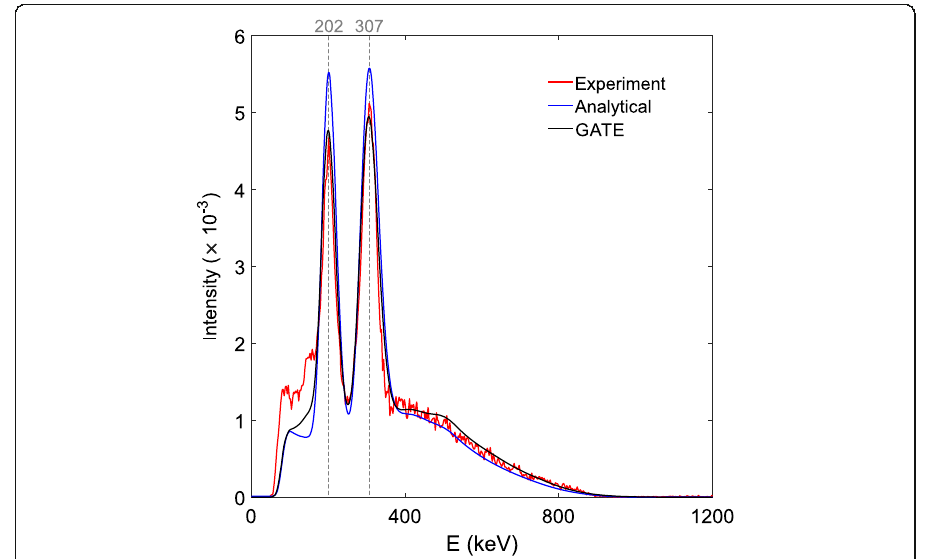
Fig. 7 Normalized coincidence energy spectra for two small LYSO cubes (10-mm side length) in contact ( d = 0 cm) measured experimentally (red), obtained analytically (blue), and simulated in GATE